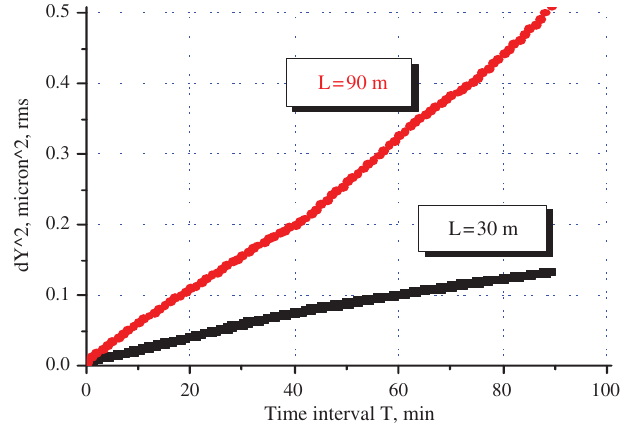
FIG. 42. (Color) Variance of the vertical relative ground motion for the points 30 and 90 m apart, measured on October 13–15, 2000 in the Aurora mine in Illinois